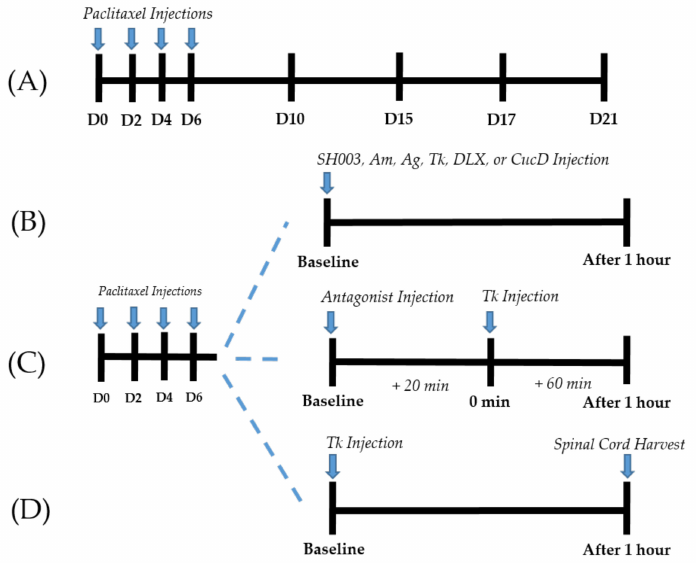
Figure 1. Experimental protocols ( A – D ). Timeline of behavioral tests conducted for paclitaxel-induced cold and mechanical allodynia assessments ( A ). Behavioral tests were conducted before (D0), 10 (D10), 15 (D15), 17 (D17), and 21 (D21) days following the first day of intraperitoneal administration of paclitaxel. Timeline of behavioral tests conducted to assess the effect of SH003, Am, Ag, Tk, DLX, and CucD ( B ). Behavioral tests were conducted before (baseline) and one hour after (After 1 h) the injection of SH003, Am, Ag, Tk, DLX, or CucD in paclitaxel-induced neuropathic pain mice. Timeline of behavioral tests conducted to clarify the role of spinal serotonergic and adrenergic receptors in Tk induced anti-allodynic effect ( C ). Antagonists were injected intrathecally 20 min before (baseline) the oral administration of Tk (0 min). Behavioral measurements were conducted twice; before the injection of antagonists (baseline) and one hour after Tk administration (After 1 h). Schedule for the ELISA assay ( D ). The L4/L5 segments of the spinal cord of mice were collected one hour after (After 1 h) the injection of Tk in paclitaxel-induced neuropathic pain